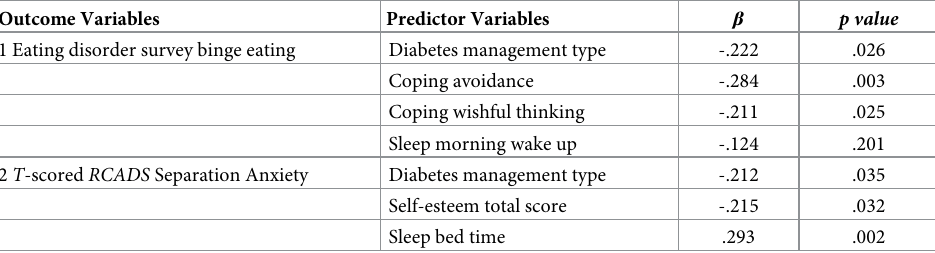
Table 7. Regression findings for diabetes group.